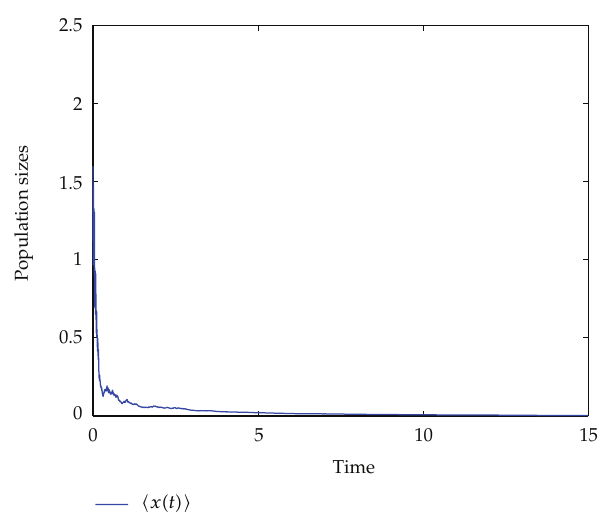
Figure 2: Stochastically nonpersistent in the mean, step size Δ t (cid:5) 0 . 001 and x (cid:3) 0 (cid:4) (cid:5) 1 .